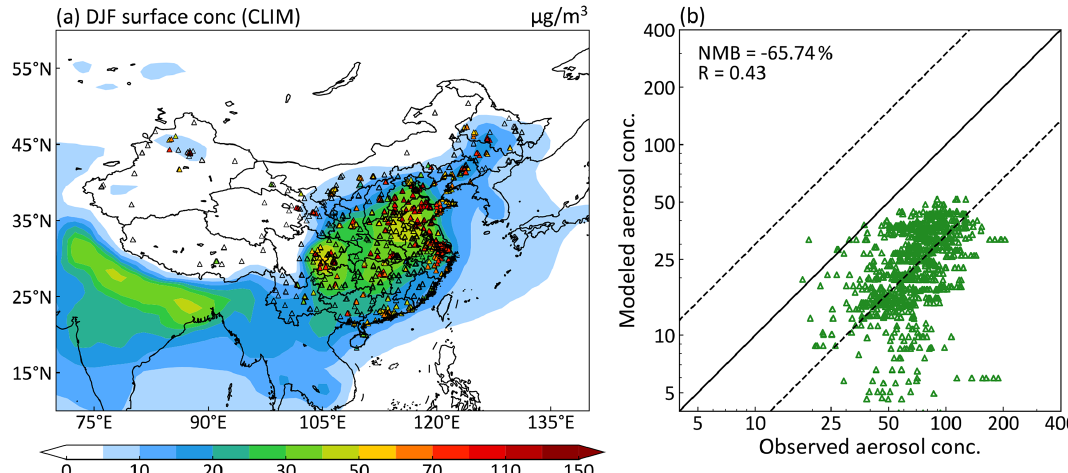
Figure 4. Spatial distributions (a) and scatter plots (b) of observed and simulated DJF mean near-surface PM 2 . 5 concentrations (µgm − 3 ) from the CLIM experiment. Solid line represents 1 : 1 ratio, and dashed lines mark 1 : 3 and 3 : 1 ratios. The observed concentrations are derived from the CNEMC in December 2014–February 2015. The normalized mean deviation (NMB) and the correlation coefficient (R) between observations and simulation are shown in the upper left corner of (b) . NMB = 100% × (cid:80) (M i − O i )/ (cid:80) O i , where M i and O i are the simulated and observed values at site i ,